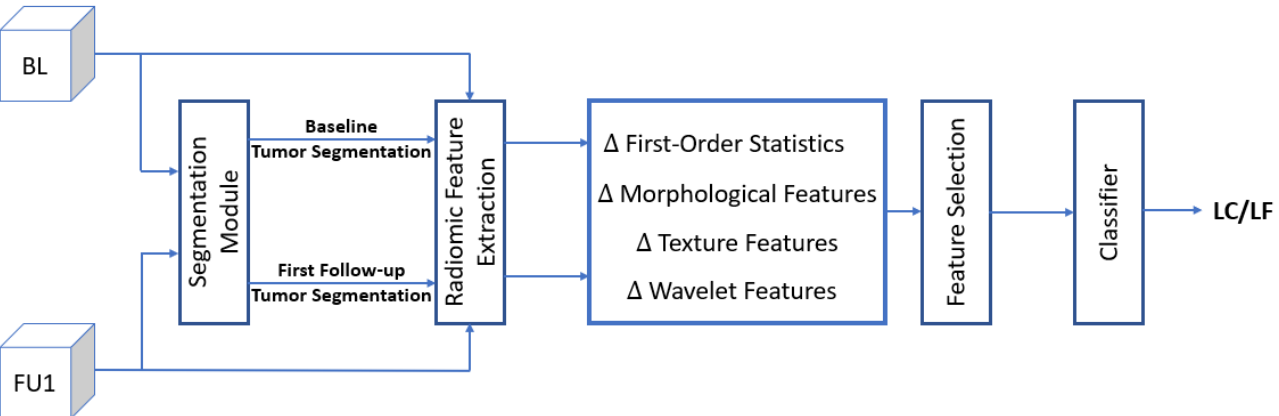
Figure 1. The overall system for SRT outcome prediction. The segmentation module segments tumours on the baseline (BL) and the first follow-up (FU1) MR images. Using the MR images and segmentation masks, different radiomic features are extracted. The features are then sorted based on their relevance/redundancy and a subset of them identified through feature selection are used to train a classifier for predicting the local outcome.